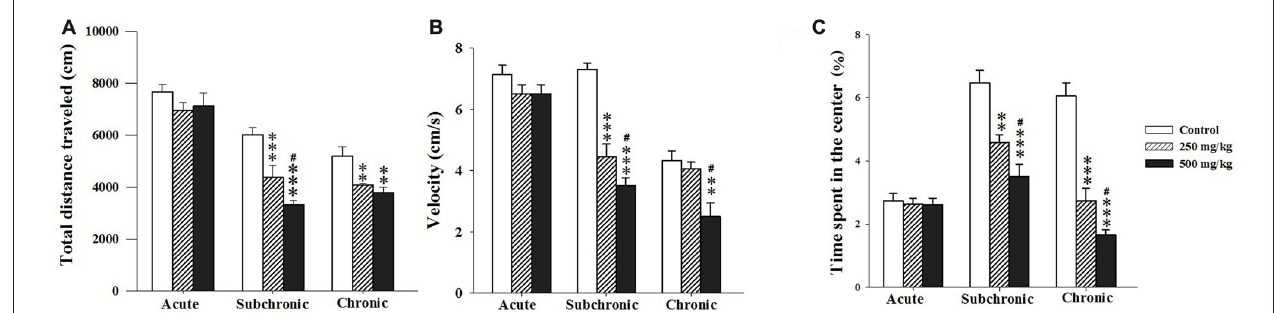
FIGURE 2 | Effect of the acute and repeated exposures to GBH on locomotor activity. (A) Total distance traveled. (B) The moving velocity. (C) The time spent in the center. Results are presented as mean ± standard error of the mean (SEM). ∗∗ P < 0.01; ∗∗∗ P < 0.001. The ∗∗∗ refers to the control vs. 250 mg/kg and 500 mg/kg group comparison and the “#” refers to the 250 mg/kg vs. 500 mg/kg group comparison. # P < 0.05: the post hoc analysis.